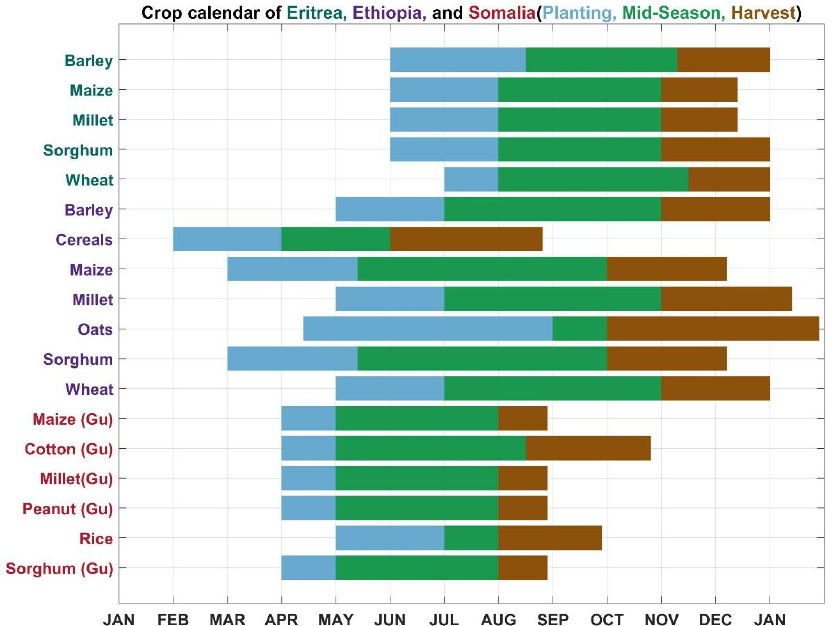
Figure 3. Crop calendar for major crops in Eritrea, Ethiopia, and Somalia. Gu indicates the Gucrop production season in Somalia.